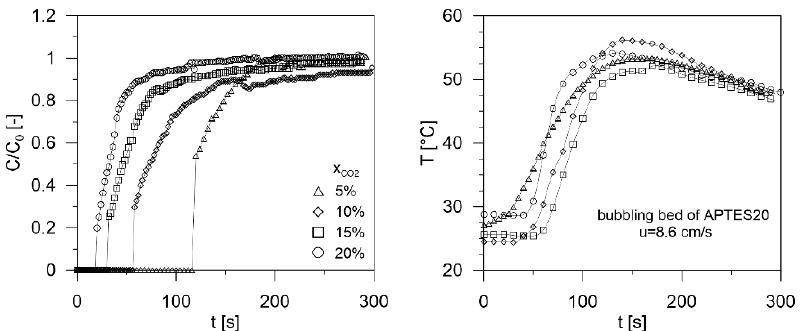
Figure 11. Breakthrough curves and corresponding temperature at different CO 2 concentrations for APTES20 in conventional bubbling bed at u = 8.6 cm/s.